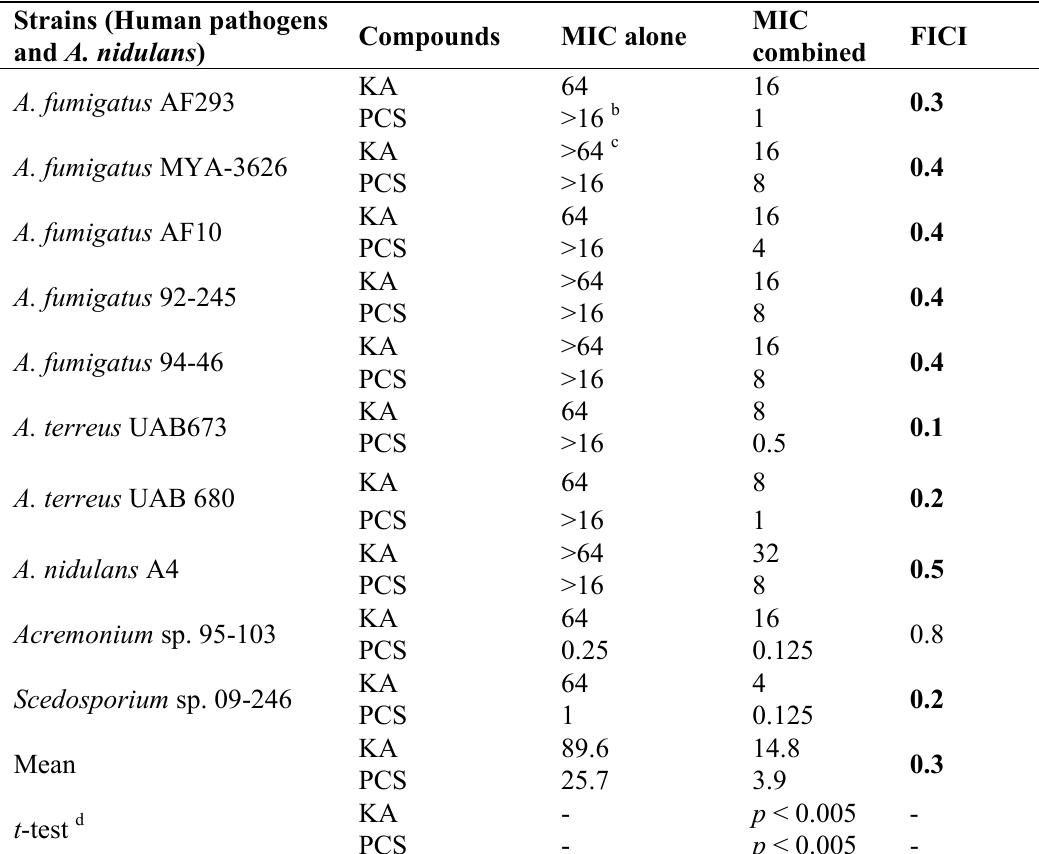
Table 3. Antifungal chemosensitization of KA (mM) to PCS ( μ g/mL) tested against filamentous fungi: summary of CLSI-based microdilution bioassays a